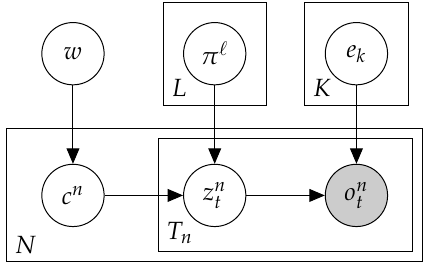
Figure 2. A plate diagram for Mix